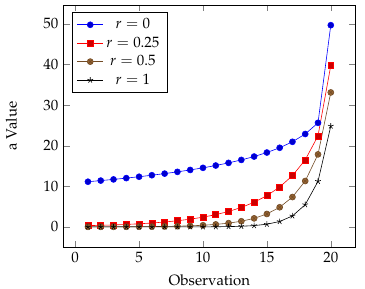
for n = 20 observations based on a normal k = 1